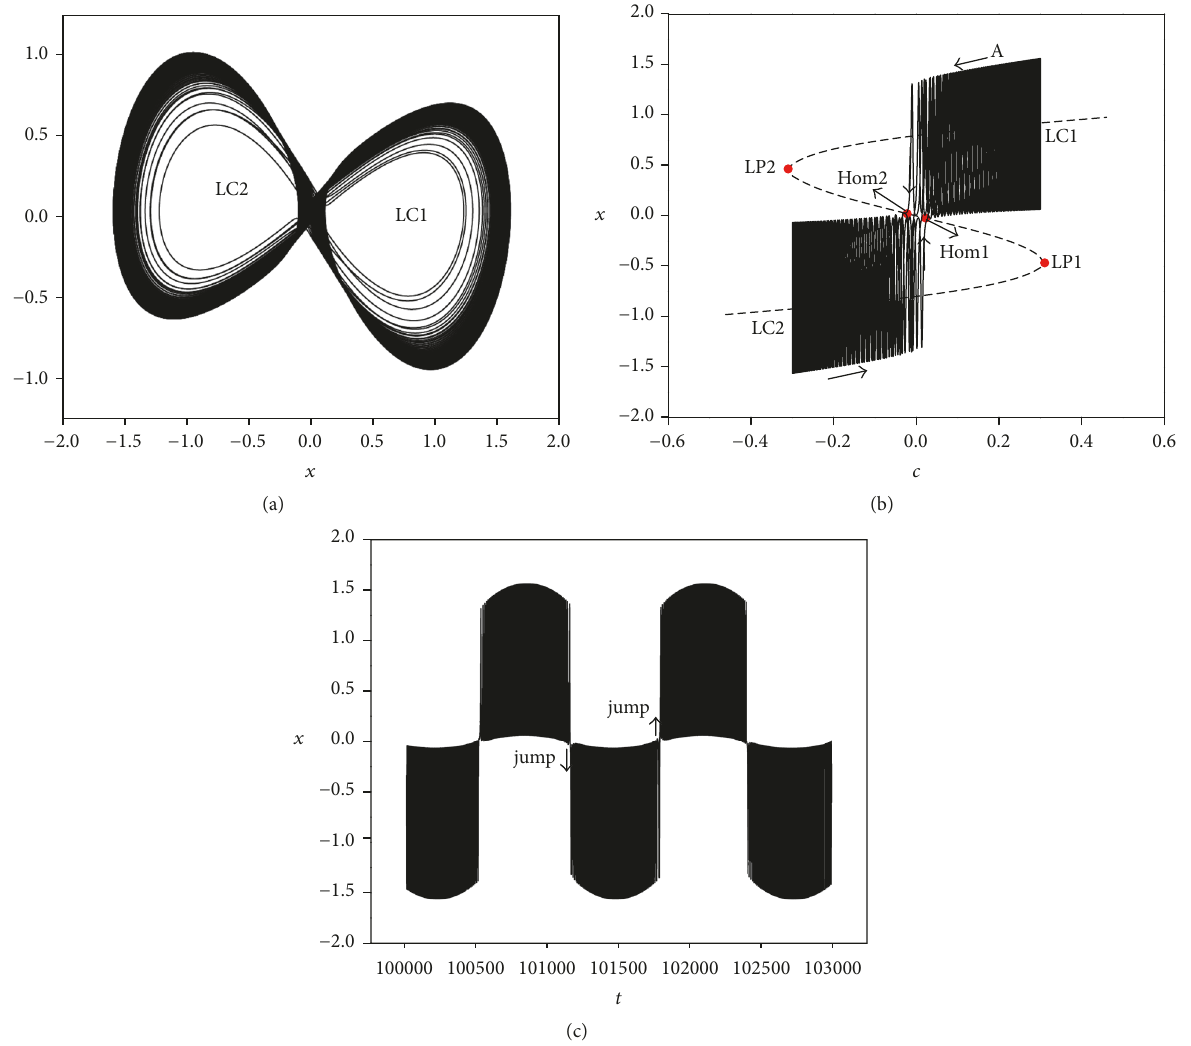
Figure 3: Bursting oscillation for 𝐴 = 0.3 . (a) Phase portrait on the (𝑥,𝑦) plane; (b) transformed phase portrait on the (𝑐, 𝑥) plane with equilibrium branches; (c) time